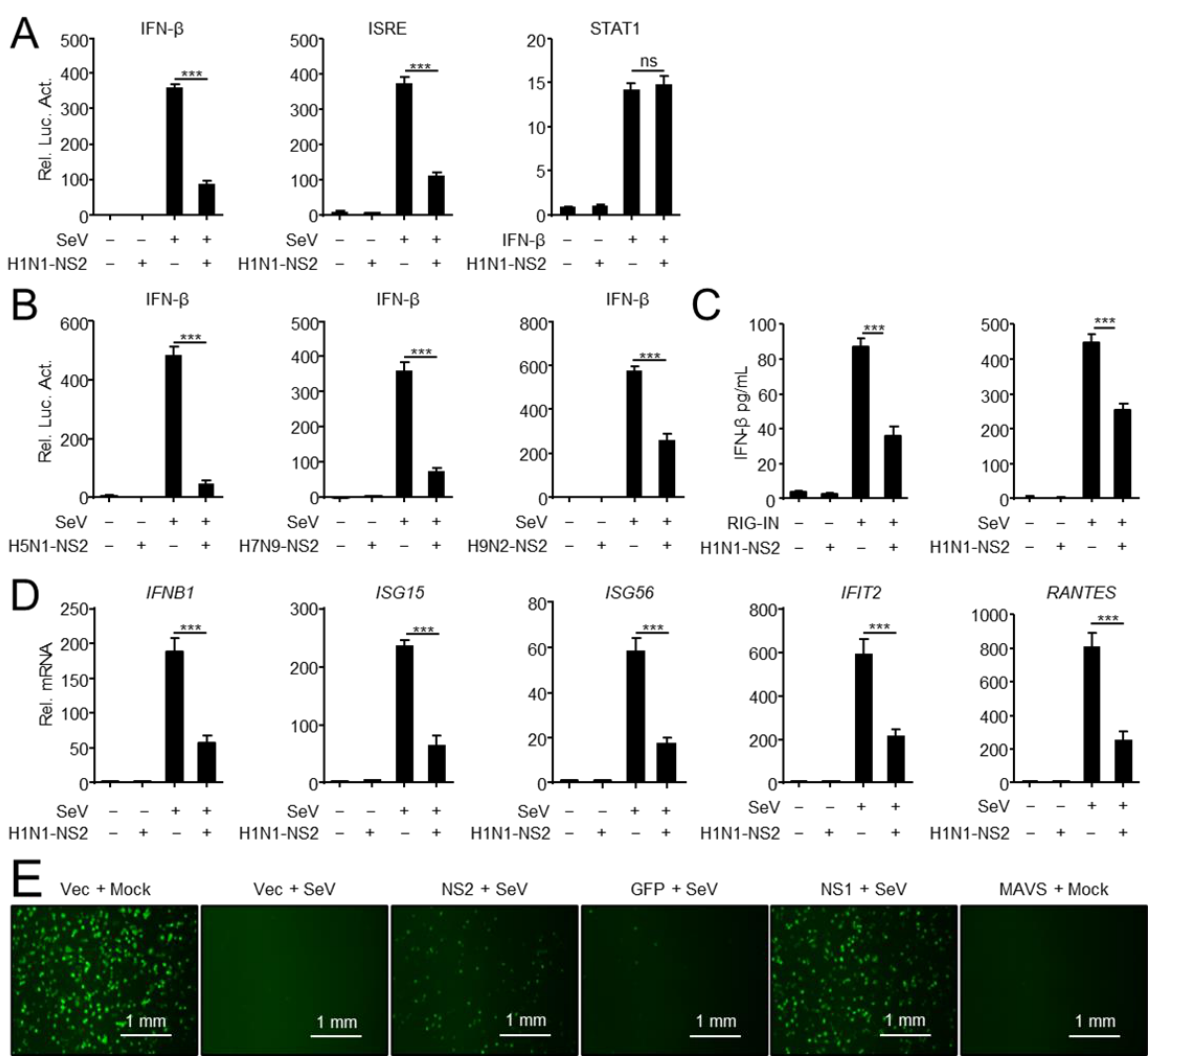
Figure 1. NS2 inhibits IFN-I induction. ( A ) NS2 specifically inhibits SeV-triggered activation of IFN- β and ISRE promoter, but not IFN- β -triggered activation of the STAT1 reporter. HEK293 cells were transfected with H1N1-NS2 (200 ng) or empty vector (Vec) and the IFN- β , ISRE or STAT1 luciferase reporter, and indicated plasmids. At twenty hours after transfection, the cells were left untreated or treated with SeV for 12 h or IFN- β for 4 h before reporter assays. ( B ) NS2 proteins from different subtypes of IAVs inhibit SeV-triggered activation of IFN- β promoter. HEK293 cells were transfected with H5N1/H7N9/H9N2-NS2 (200 ng) or Vec and IFN- β luciferase reporter and indicated plasmids. At twenty hours after transfection, cells were left uninfected or infected with SeV for 12 h before reporter assays. ( C ) The effects of overexpressed NS2 on RIG-IN and SeV-induced IFN- β secretion. HEK293 cells were transfected with H1N1-NS2 (200 ng) or Vec, and subsequently transfected with RIG-IN or infected with SeV. The concentration of IFN- β in supernatants was determined using human IFN- β DuoSet ELISA kit. ( D ) NS2 inhibits SeV-triggered transcription of IFN- β and downstream genes. A549 cells were transfected with Flag-NS2 or Vec, and subsequently left uninfected or infected with SeV (MOI = 1) for 12 h before qPCR analysis. ( E ) NS2 facilitates VSV-GFP replication. HEK293 cells were transfected with indicated plasmids for 24 h, and cells were then infected with SeV (MOI = 1) or not (Mock) for 24 h. Cell supernatants were inactivated by ultraviolet radiation for 20 min and collected to treat fresh HEK293 cells for another 24 h. Cells then were infected with VSV-GFP (MOI = 0.01) for 12 h, and then observed microscopically. Scale bar, 1 mm. The data shown represent three independent experiments ( p < 0.05 (*), p < 0.01 (**), p < 0.001 (***); ‘ns’ indicates no significant